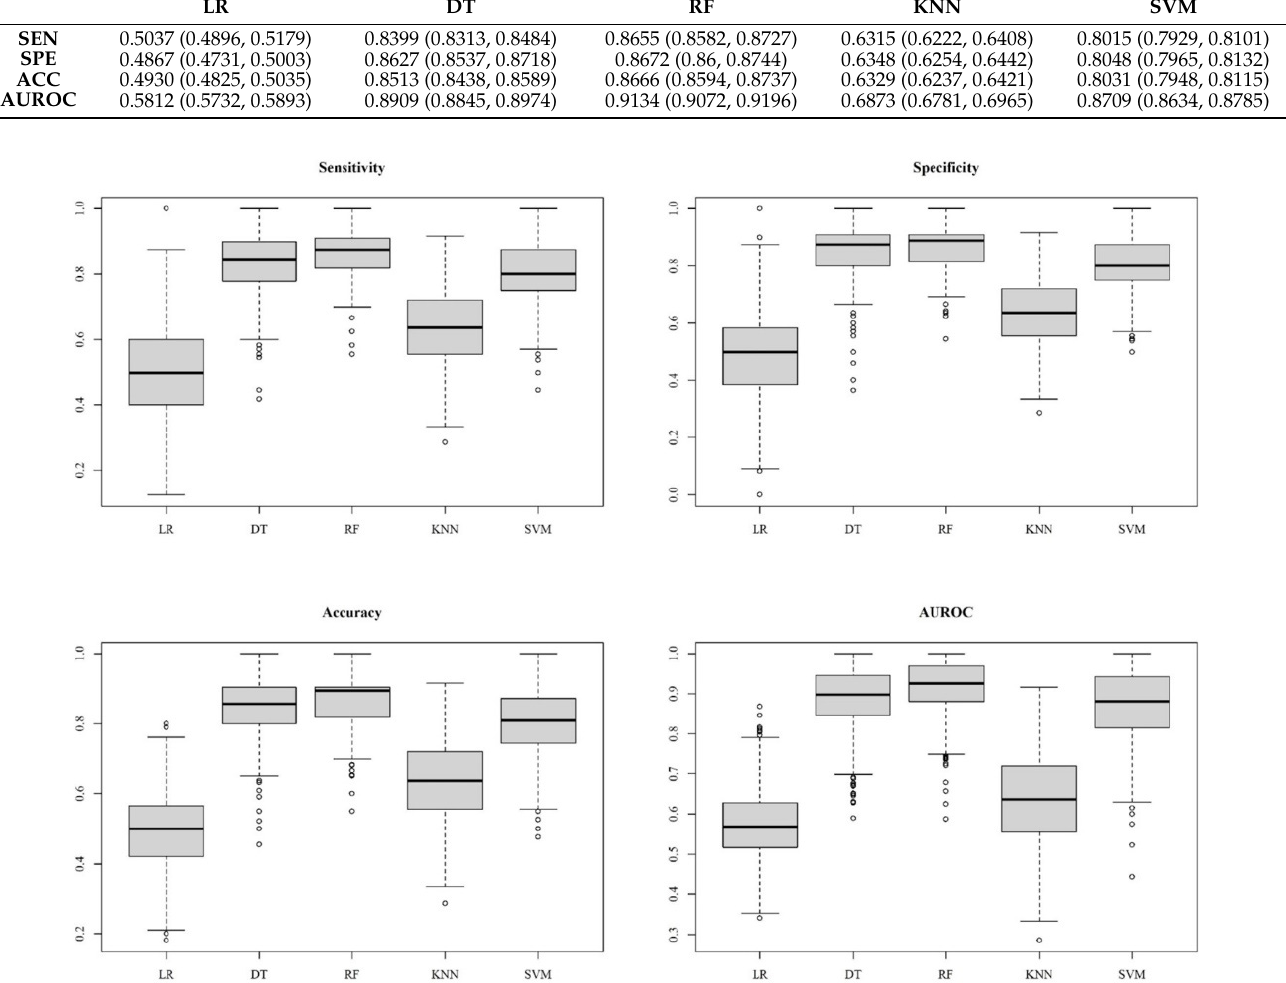
Figure 7. Diagnostic performance of the models. Sensitivity, specificity, accuracy, and area under the receiver operating characteristic curve (AUROC) for the models with various algorithms. Amid the algorithms, RF, and DT outperform other algorithms.